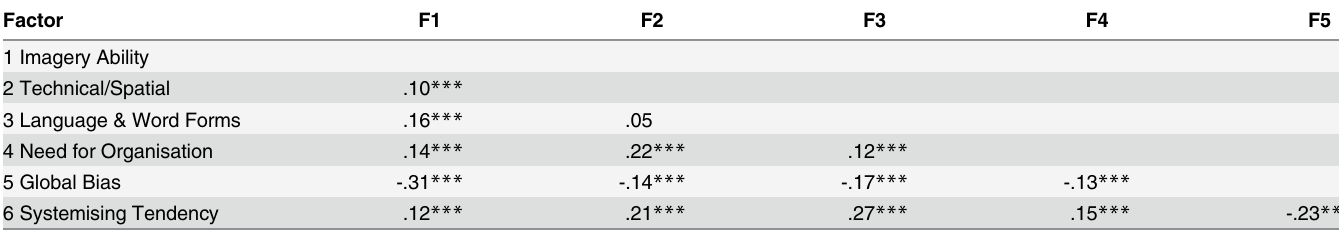
Table 2. Correlation coefficients (Pearson ’ s r ) between scores on the scales of the SCSQ.